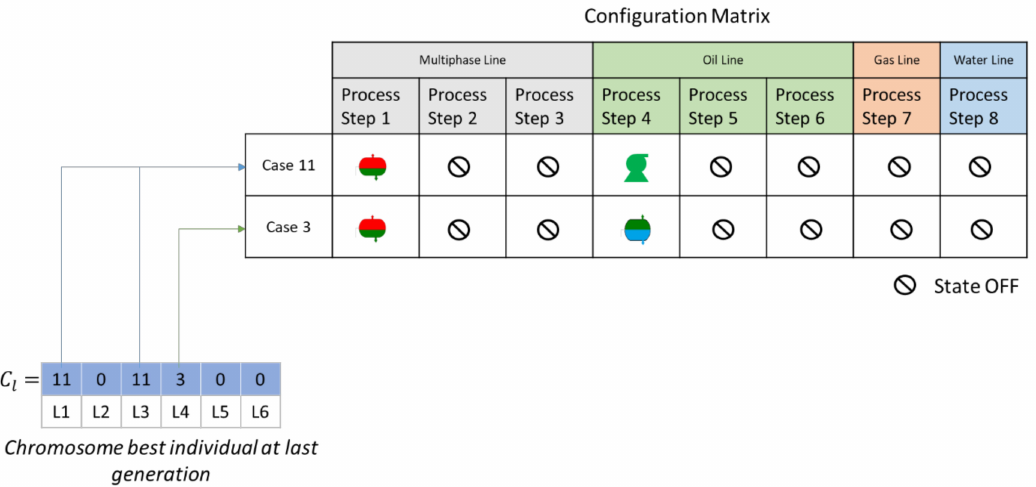
Figure 15. Business Case Solution.